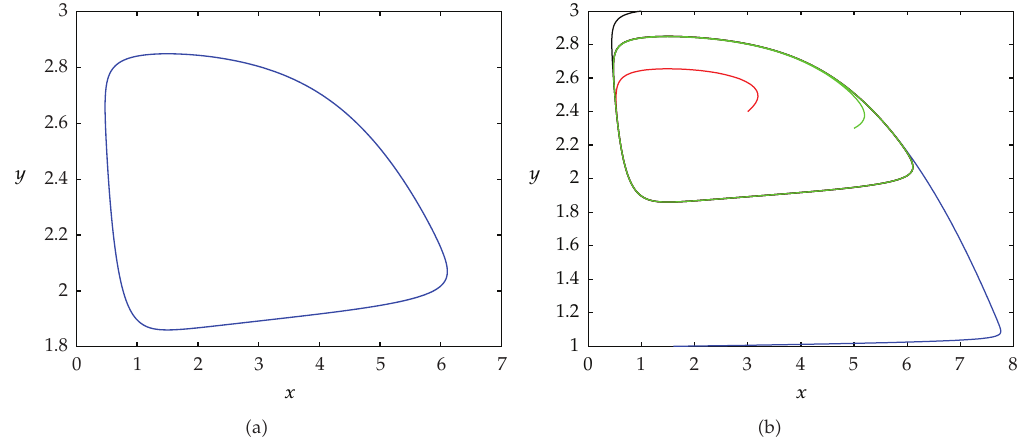
Figure 3: The dynamical behaviors of system (cid:4) 2.1 (cid:5) when α (cid:6) 0 . 5, k (cid:6) 0 . 2, β (cid:6) 0 . 5, a (cid:6) 1, b (cid:6) 0 . 1, c (cid:6) 0 .